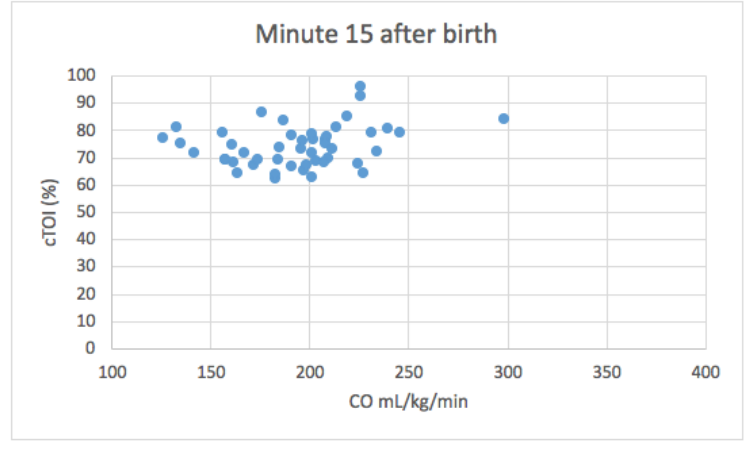
Figure 2. Correlation analyses between CO and cTOI at minute 5, 10, and 15 after birth.